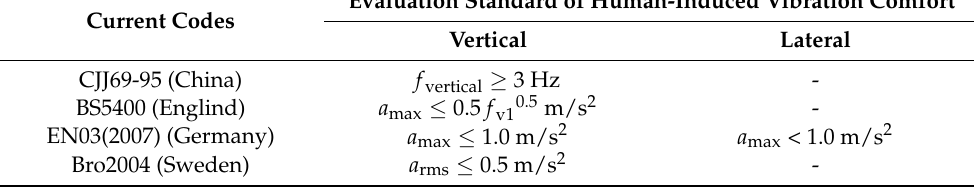
Table 3. Current codes on human-induced vibration at home and